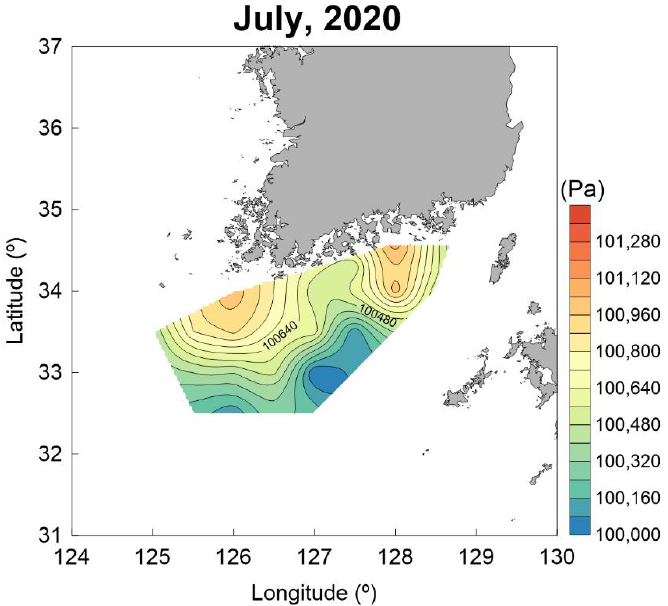
Figure 13. Distribution of atmospheric pressure in the Southern Sea and Jeju coastal waters.